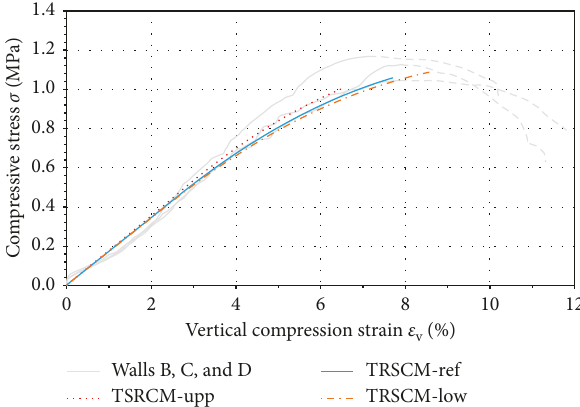
Figure 14: (a) Principal tensile strains and (b) extent of plastic zones obtained for the displacement-controlled analyses for a vertical strain ε of about 8% (right after the reaching of the compressive strength).